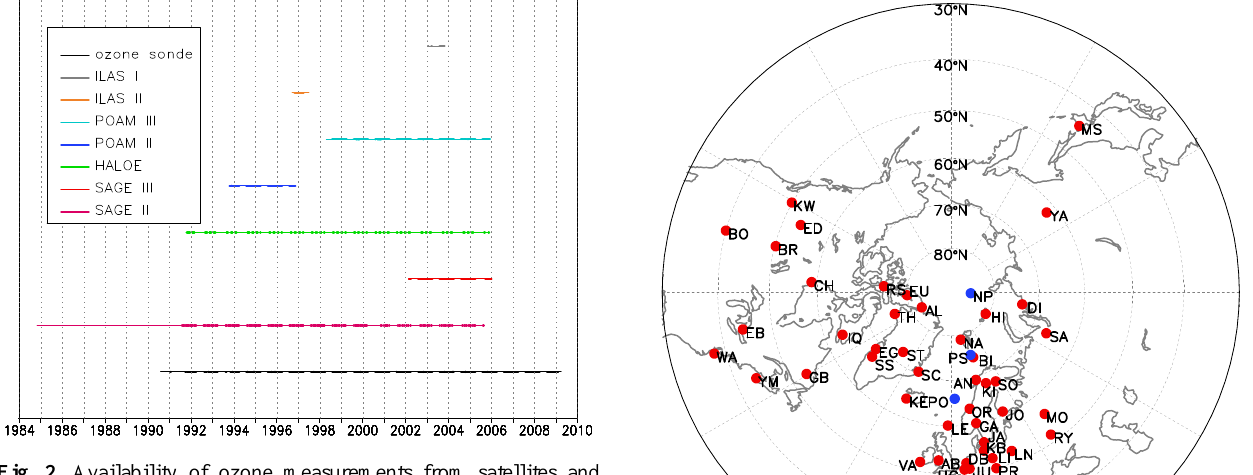
Fig. 2. Availability of ozone measurements from satellites and ozone sondes from 1991 to 2009.